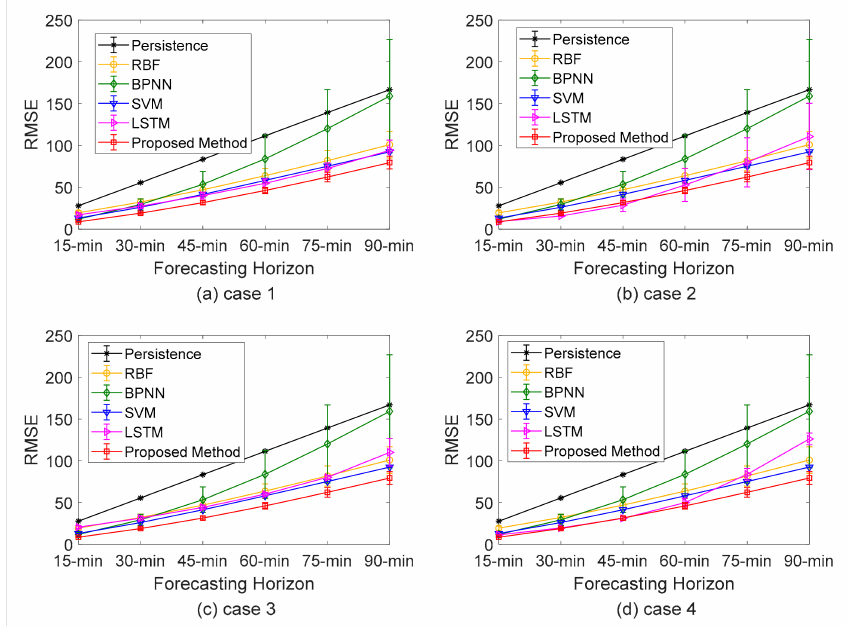
Figure 11. RMSE statistics in terms of various forecasting